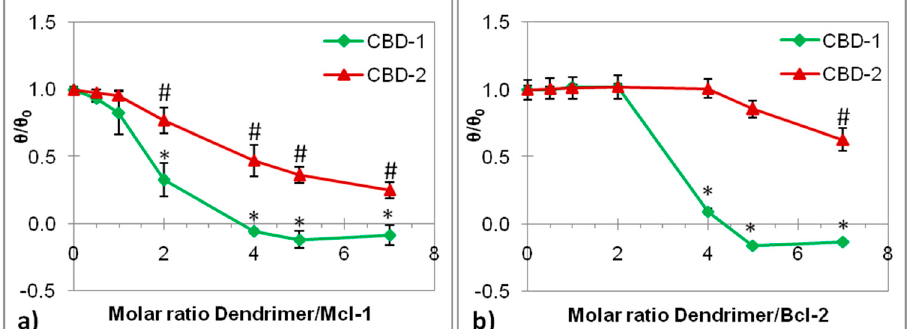
Figure 3. Changes in mean residue ellipticity of Mcl-1 ( a ) and Bcl-2 ( b ) at λ = 265 nm in the presence of the following dendrimers: CBD-1 and CBD-2. siRNA concentration = 2 μ M; wavelength, 200–300 nm; bandwidth, 1.0 nm; response time, 4 s; scanning speed, 50 nm/min; step resolution, 0.5 nm. Na-phosphate buffer 10 mmol/L, pH 7.4. Results are presented as mean ± SD from a minimum of 3 independent experiments. * p < 0.05 compared to siRNA (after addition of CBD-1); # p < 0.05 compared to siRNA (after addition of CBD-2).